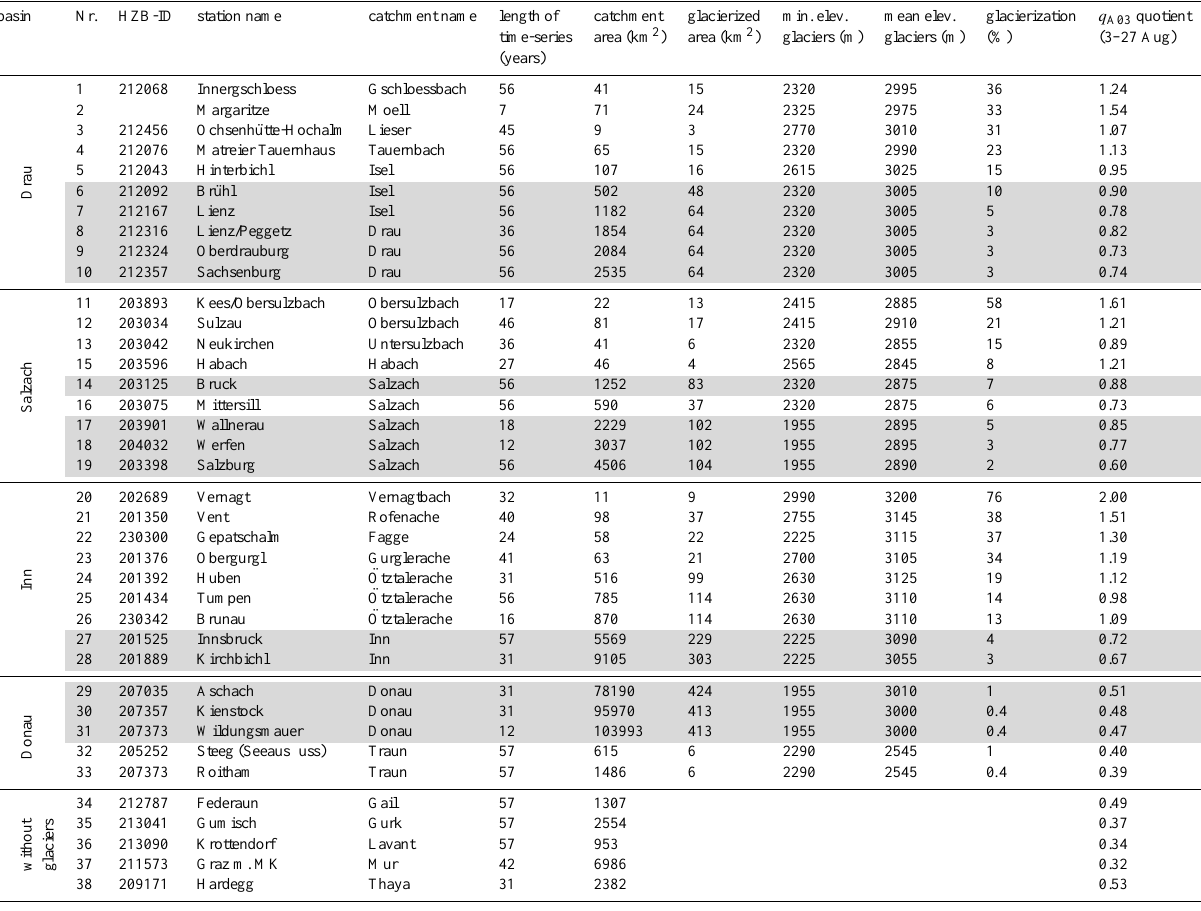
Table 2. Overview and results of investigated basins and stations (grey background indicates corrected catchtment area and glacierized areas).